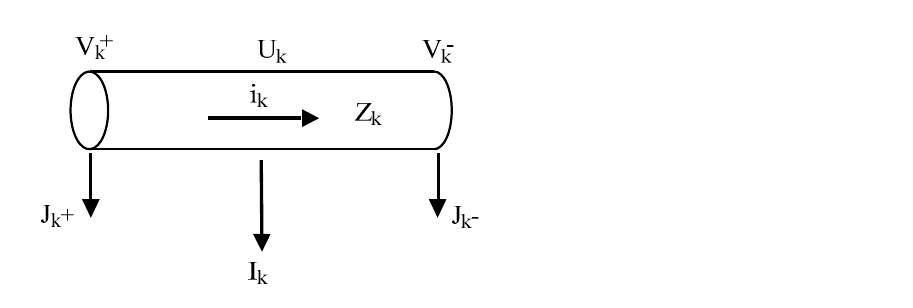
Figure 3. An outline of some of the magnitudes used on the k branch.